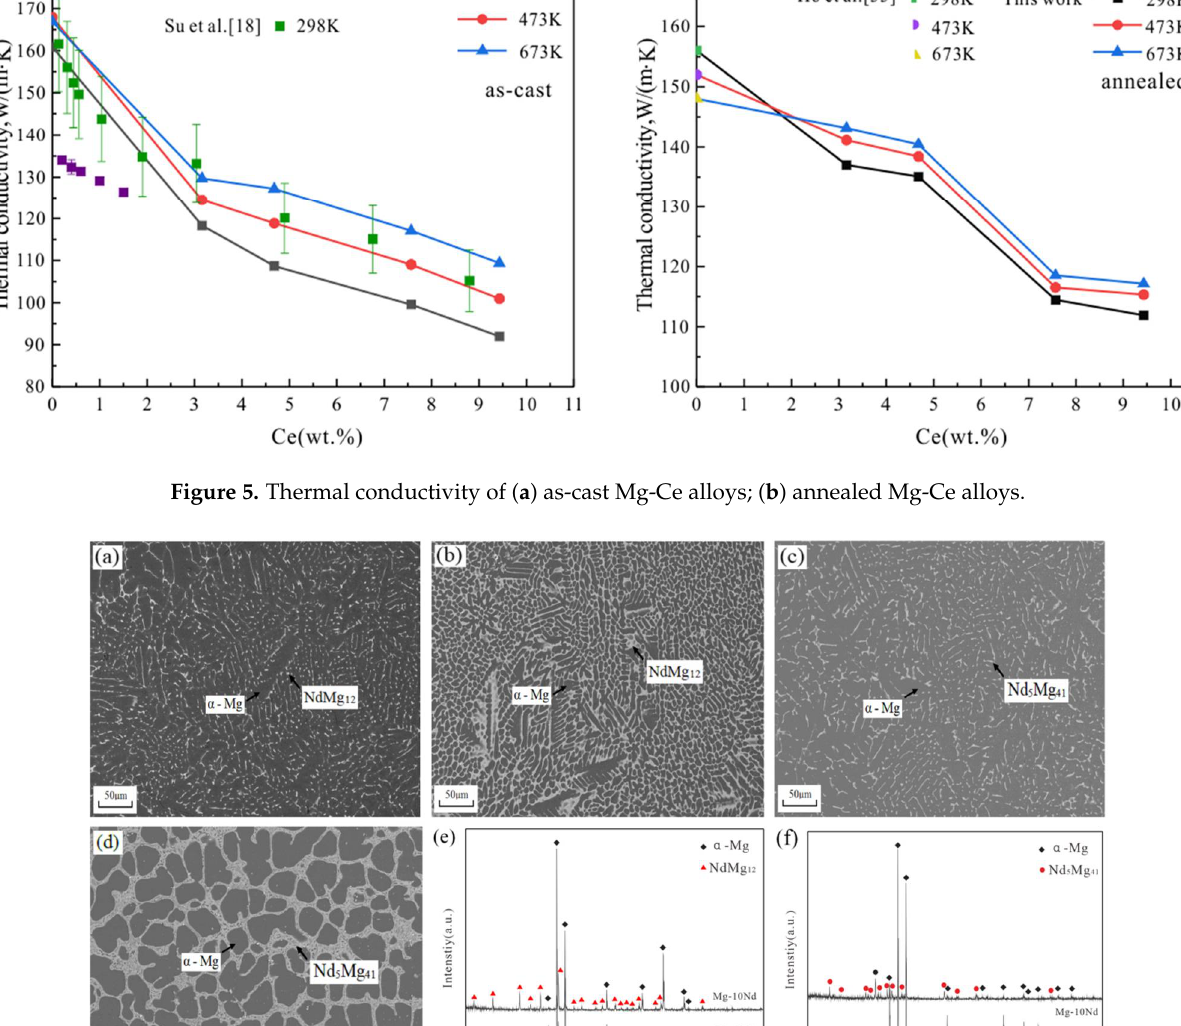
Figure 7. Thermal conductivity of ( a ) as-cast Mg-Nd alloys; ( b ) annealed Mg-Nd alloys.